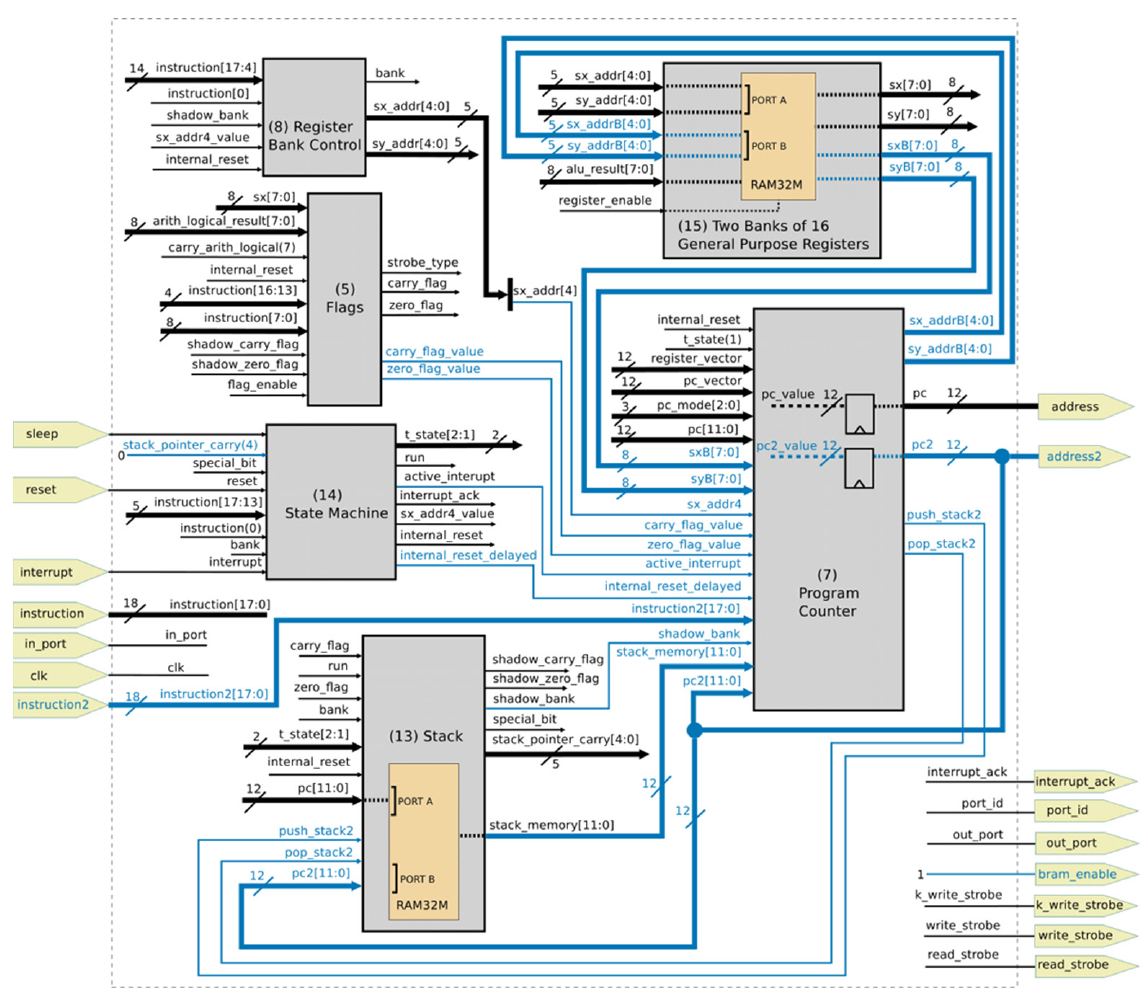
Figure 10. Zipi8 schematic with added prediction signals (highlighted in blue)—ALU, decoder, and SPM modules are omitted as these modules remain unchanged.